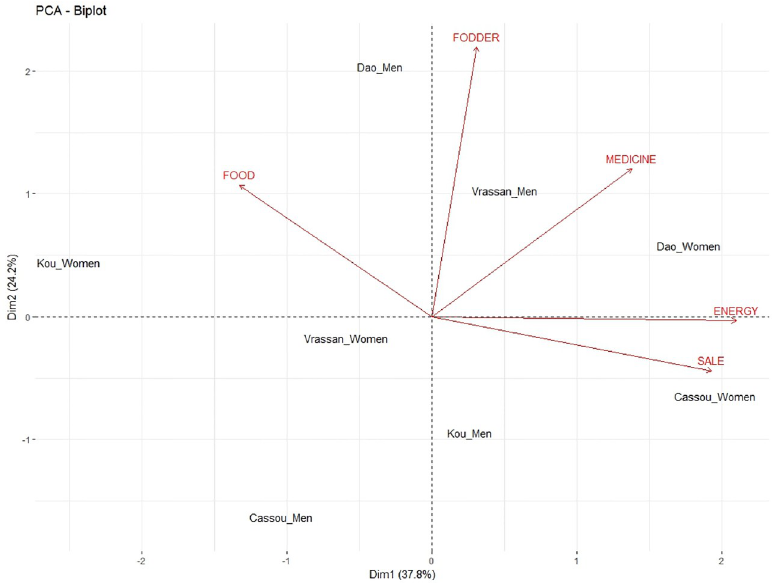
Fig 5. Biplot of the Principal Component Analysis assessing the relationship between gendered groups and woody vegetation attributes in the studied landscape of the four villages (Cassou, Dao, Kou and Vrassan) in Ziro province of Burkina